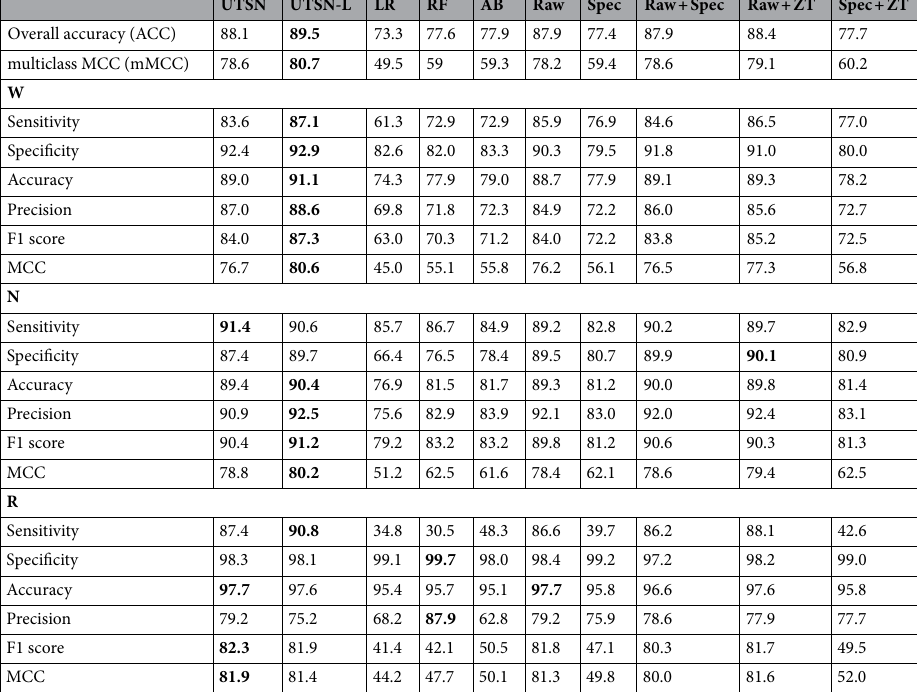
Table 1. Prediction performance from validation . Average scores from the three sets of training and validation sessions. LR logistic regression, RF random forest (64 estimators), AB AdaBoost (64 estimators), Raw raw signal, Spec spectrum, W wakefulness, N NREM, R REM. The best result for each criterion is indicated in bold. For details, see Suppl. Fig.